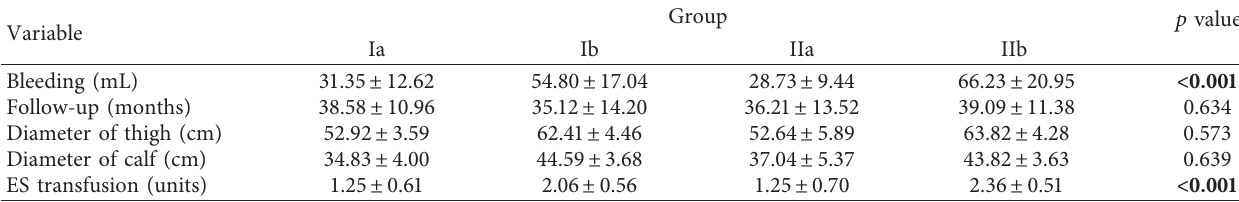
Table 2: A comparative overview of clinical and perioperative variables under